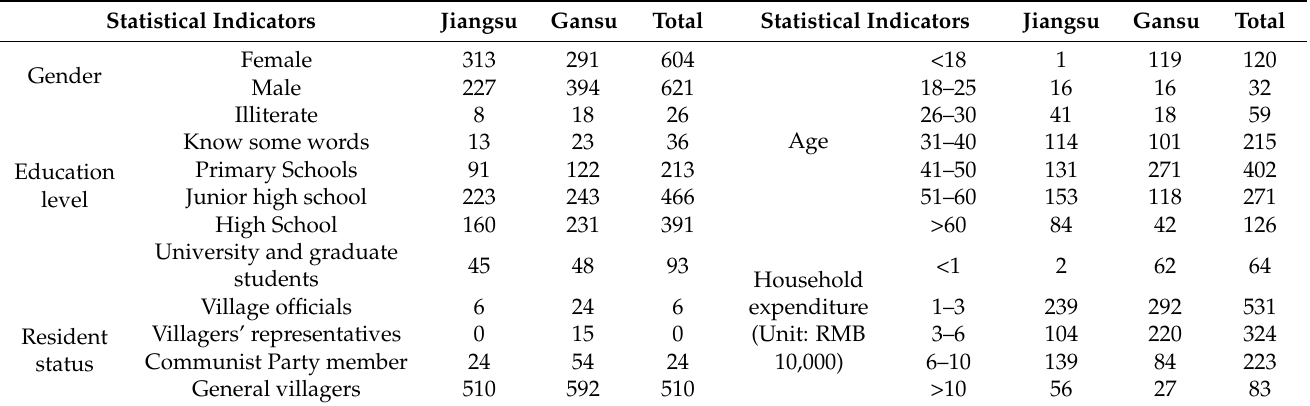
Table 1. Sample distribution